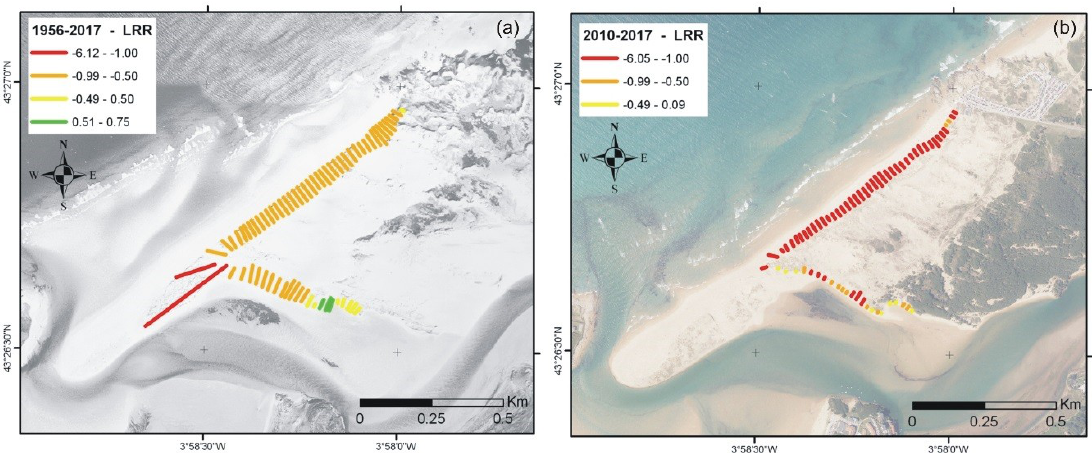
Figure 6. DSAS results for the Linear Regression Rate (LRR) statistical parameter (m year −1 ) at the Oyambre dune system, for the entire time period ( a ) and post-storm period ( b ).